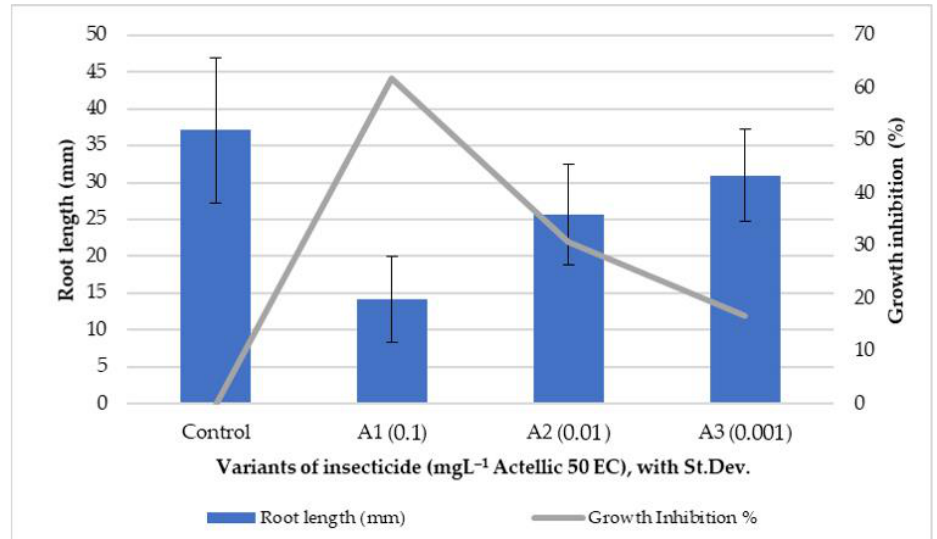
Figure 1. Root growth inhibition of Sorghum saccharatum after 3 days of exposure.